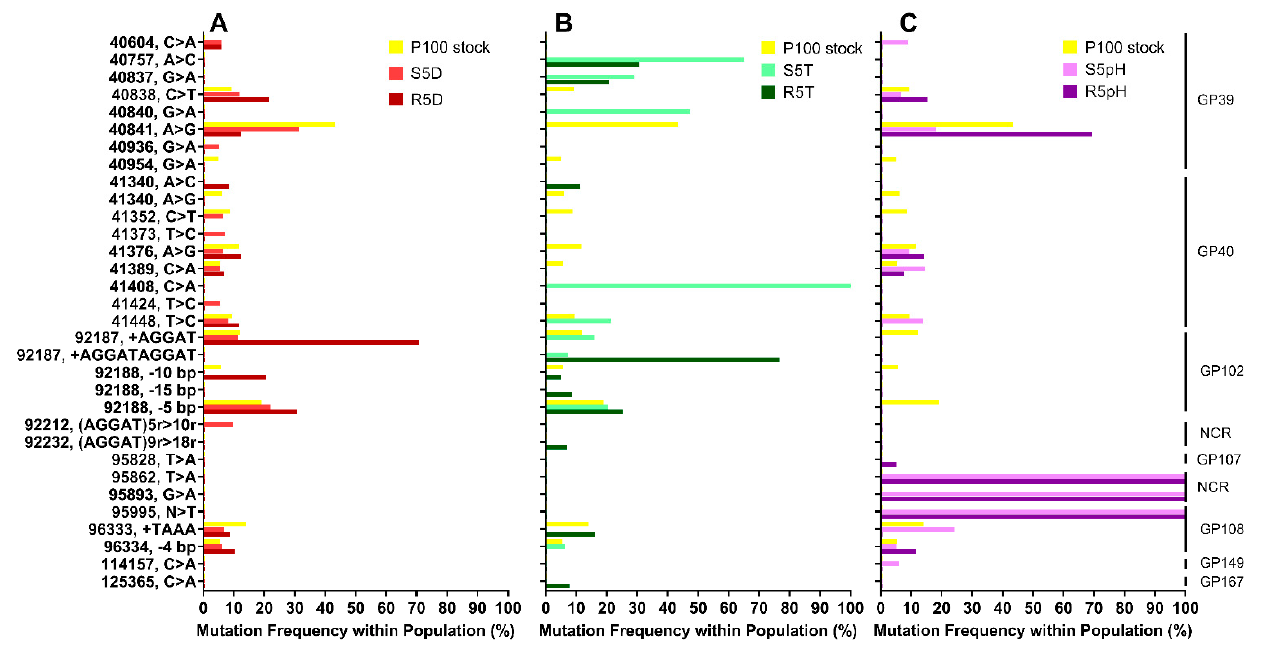
Figure 3. Mutation frequency for the P100 stock (yellow) and ( A ) the desiccation-selected S5D (light red), R5D (dark red) samples, ( B ) the heat-selected S5T (light green), R5T (dark green) samples, and ( C ) the acid-selected S5pH (light purple), and R5pH (dark purple) samples as compared to a reference P100 genome (NCBI Accession NC_007610.1) [34]. The location and type of mutation are shown in the left axis, where “-” refers to a deletion, “+” refers to an insertion, and “r” refers to a repeated segment. The hypothetical gene protein corresponding to each mutation is annotated on the far right. Abbreviations: GP: gene product; NCR: non-coding region. Nomenclature: S5D: P100 sample that underwent 5 cycles of desiccation selection; R5D: S5D sample that was propagated 5 times in